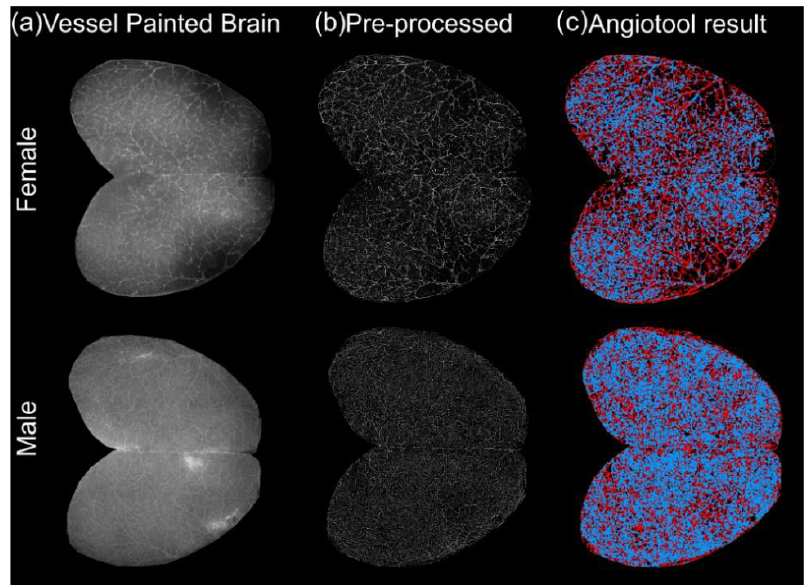
Figure 2. Quantitative workflow for axial cortical surface vascular assessments in 1 to 3-month-old 3xTg-AD mice. ( a ) Exemplar vessel painted brains from male and female 3xTg-AD mice. ( b ) Vessel painting images are pre-processed by binarizing images and then subjected to haze reduction using the Keyence BZ-X800 Analyzer. ( c ) The pre-processed images are then analyzed using Angiotool, which results in output images where vessels are represented in red and junctions/branching points in blue.